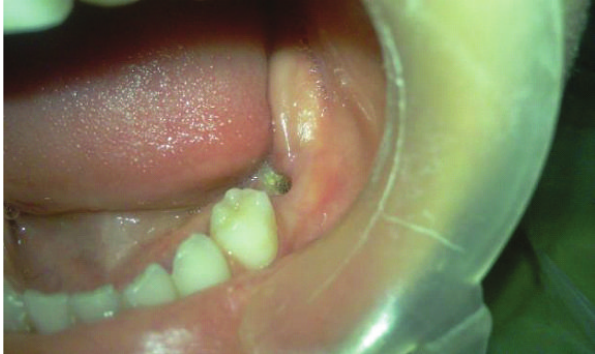
Figure 2: Radiographic view of the left second submerged primary mandibular molar.